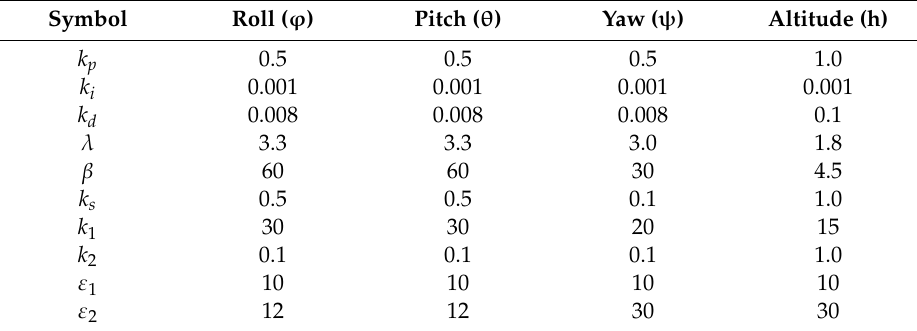
Table 3. Parameters of the proposed RDSMC-NDO for simulation.